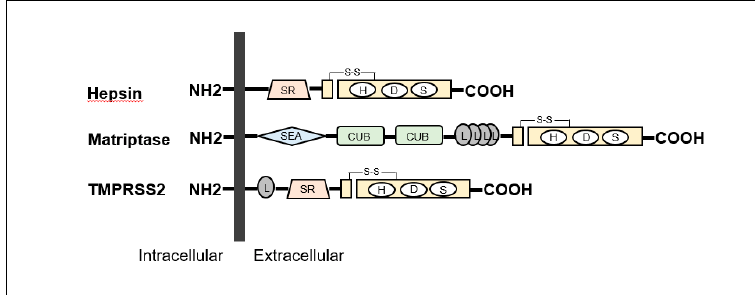
Figure 2. Structures of hepsin, matriptase and transmembrane protease serine (TMPRSS) 2 are shown. All type II transmembrane serine proteases (TTSPs) show single-pass transmembrane proteins with intracellular NH2-terminus and extracellular carboxy-terminal serine protease domains. Hepsin is composed of scavenger receptor (SR) and serine protease domains. Matriptase contains sea urchin sperm protein / enteropeptidase / agrin (SEA) domain, Cls / Cls, urchin embryonic growth factor, bone morphologic protein-1 (CUB) domain, four low-density lipoprotein receptor (L) domains class A and serine protease domains. TMPRSS2 is consists of an L domain, SR, and serine protease